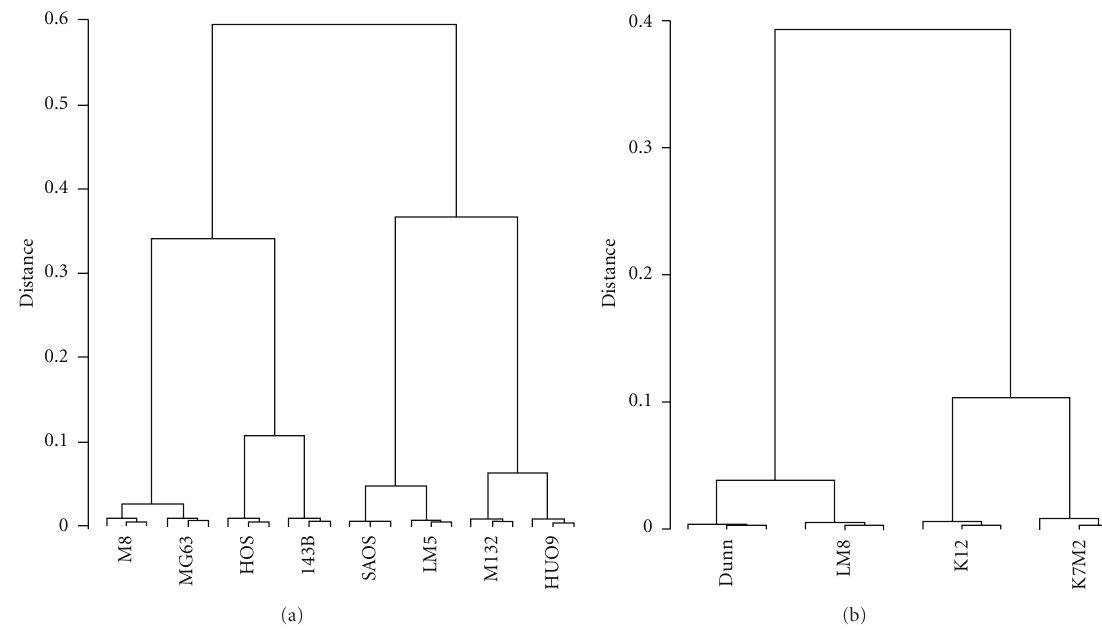
Figure 1: (a) Dendrogram of gene expression levels in the four human OS cell line systems. (b) Dendrogram of gene expression levels in the two mouse OS cell line systems. All probe sets on the arrays were included in the